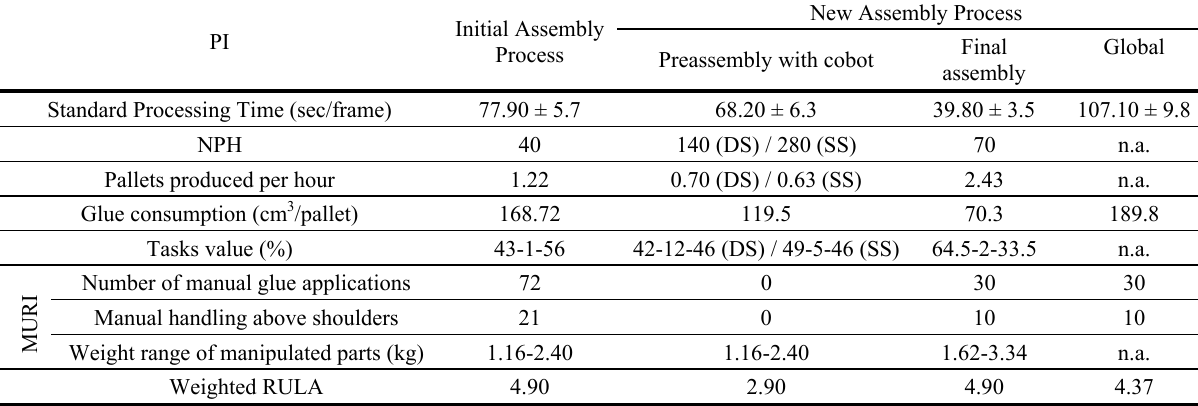
New Assembly Process